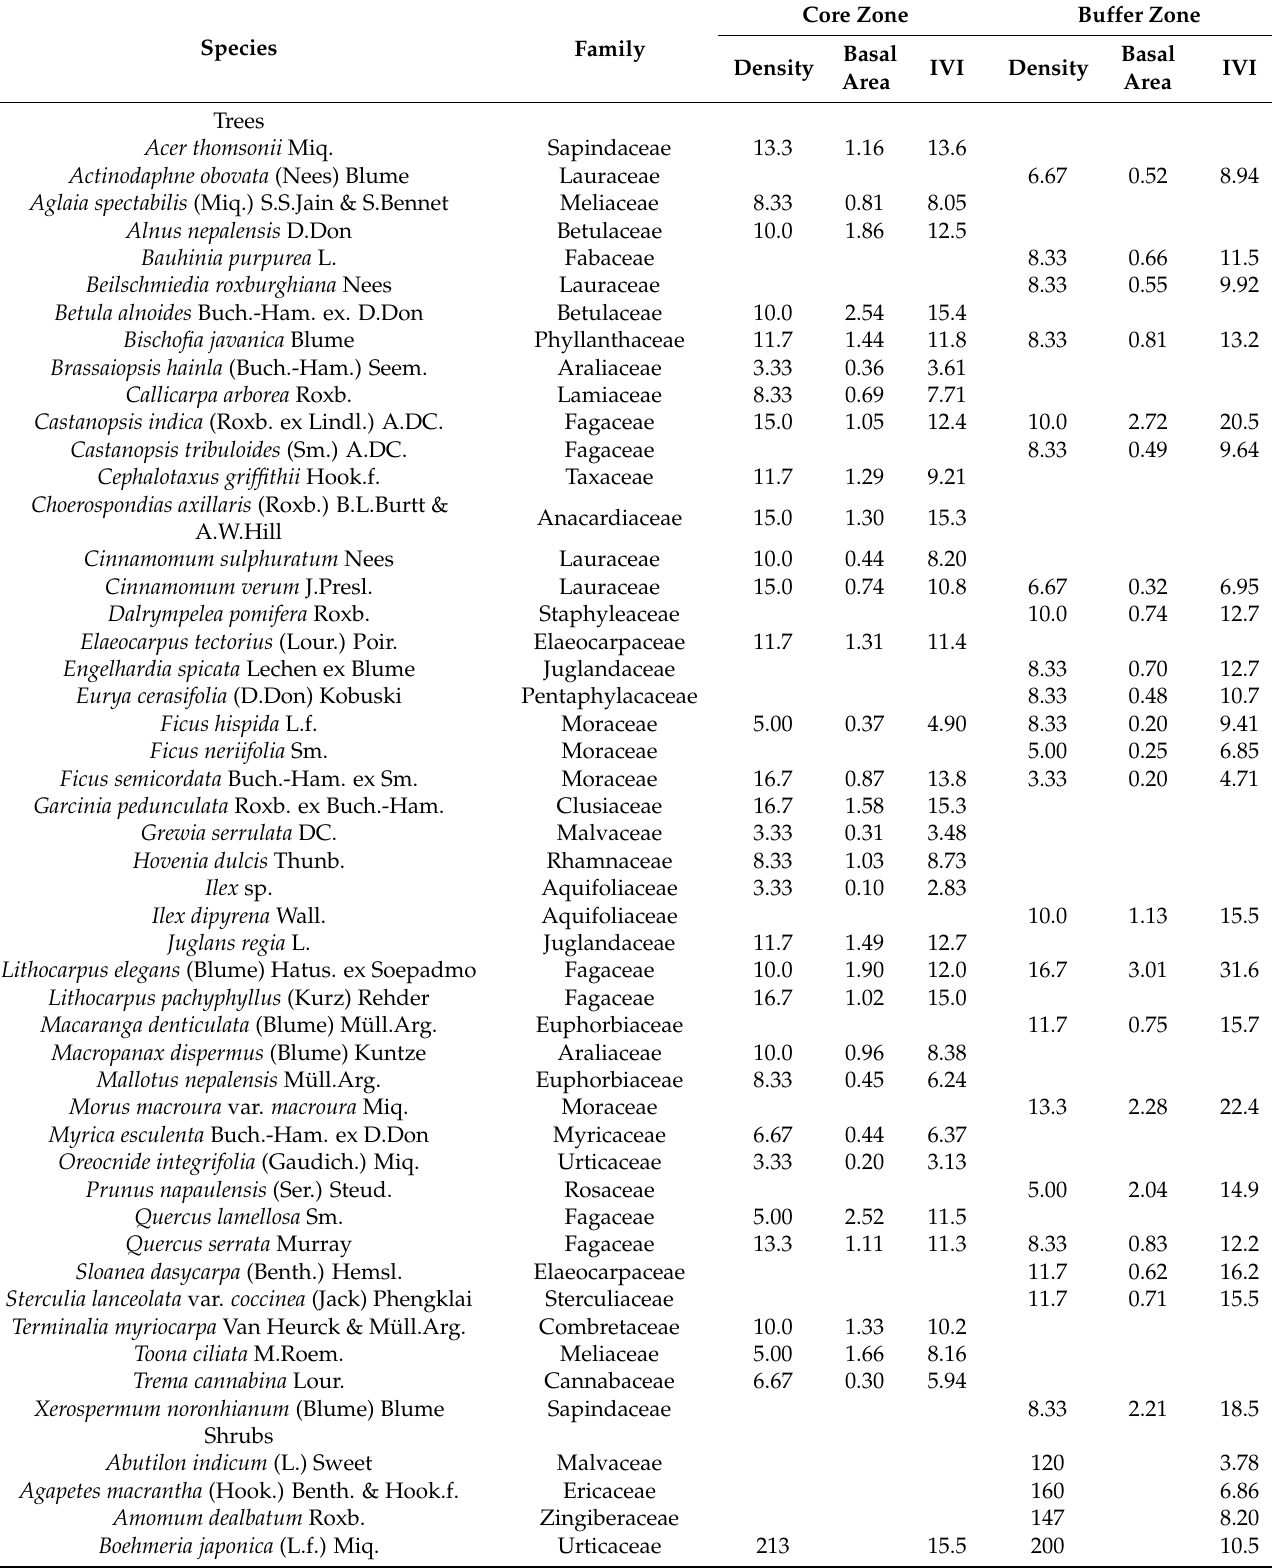
Table 2. Density (individuals ha − 1 ), basal area (m 2 ha − 1 ), and important value index (IVI) of trees, shrubs, and herbs in core and buffer zone of Minkong Community Reserve Forest, Nagaland, India. Species Family